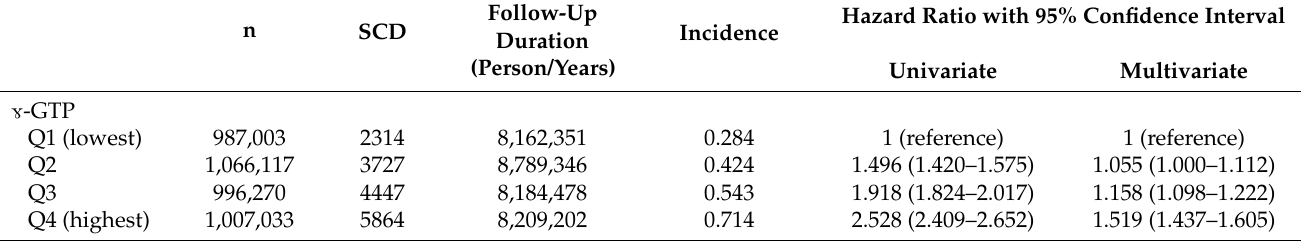
Table 4. Impact of È -GTP level on SCD